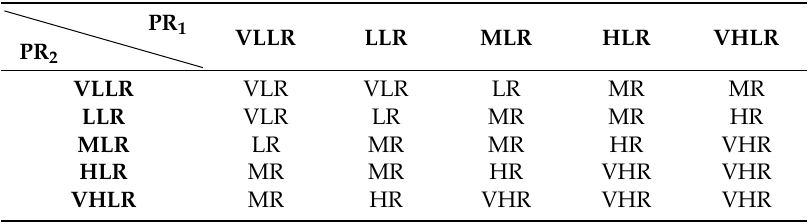
Table 4. Rule design for